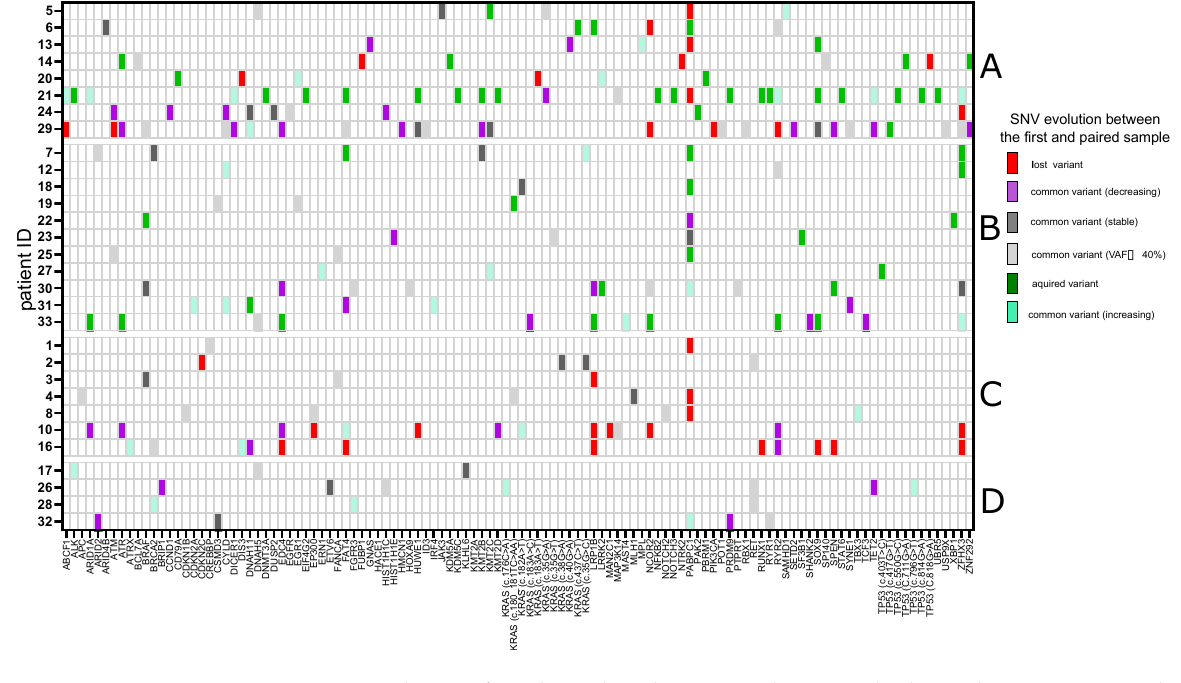
Figure 3. Evolution of single-nucleotide variants during multiple myeloma progression based on the next-generation sequencing data from the first and paired samples. Description: A—patients who presented a branching evolution with mutations lost and gained during multiple myeloma progression; B—patients who only acquired new mutations during multiple myeloma progression; C—patients who only lost mutations during multiple myeloma progression; D—patients with stable mutations during multiple myeloma progression.